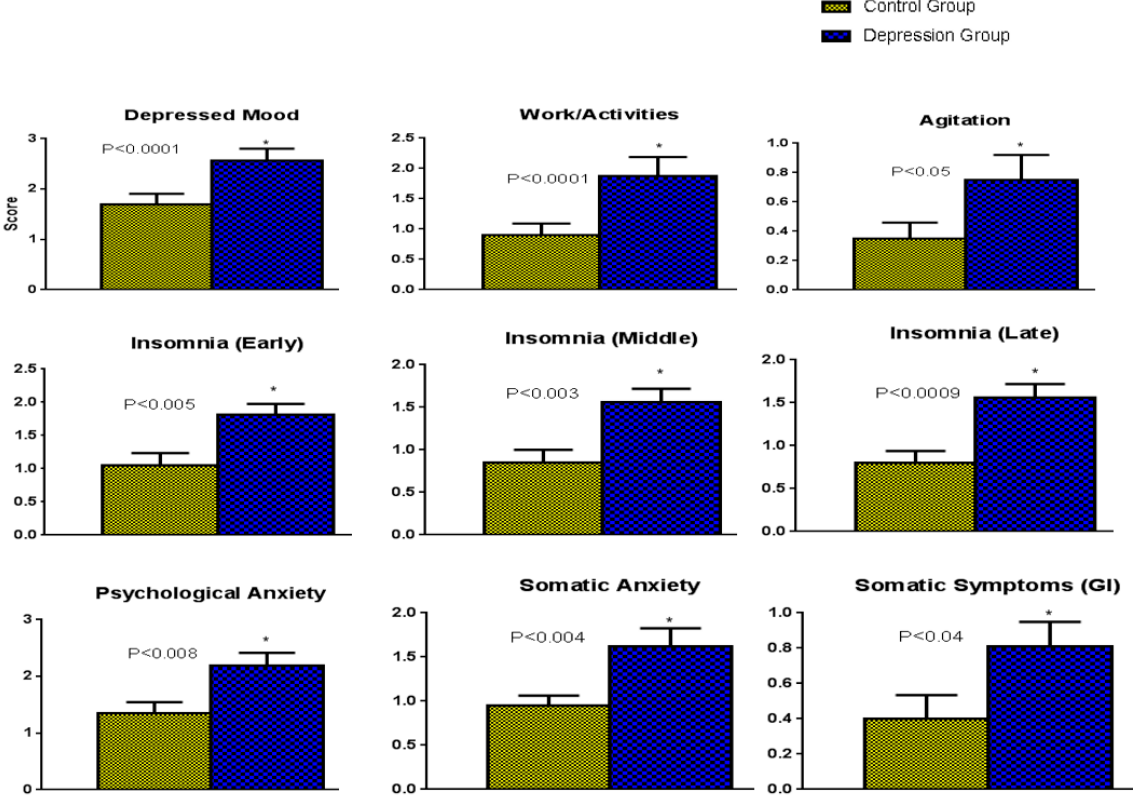
Figure 2. The comparison of the different items on the HAM-D scale between depression and control group of participants.